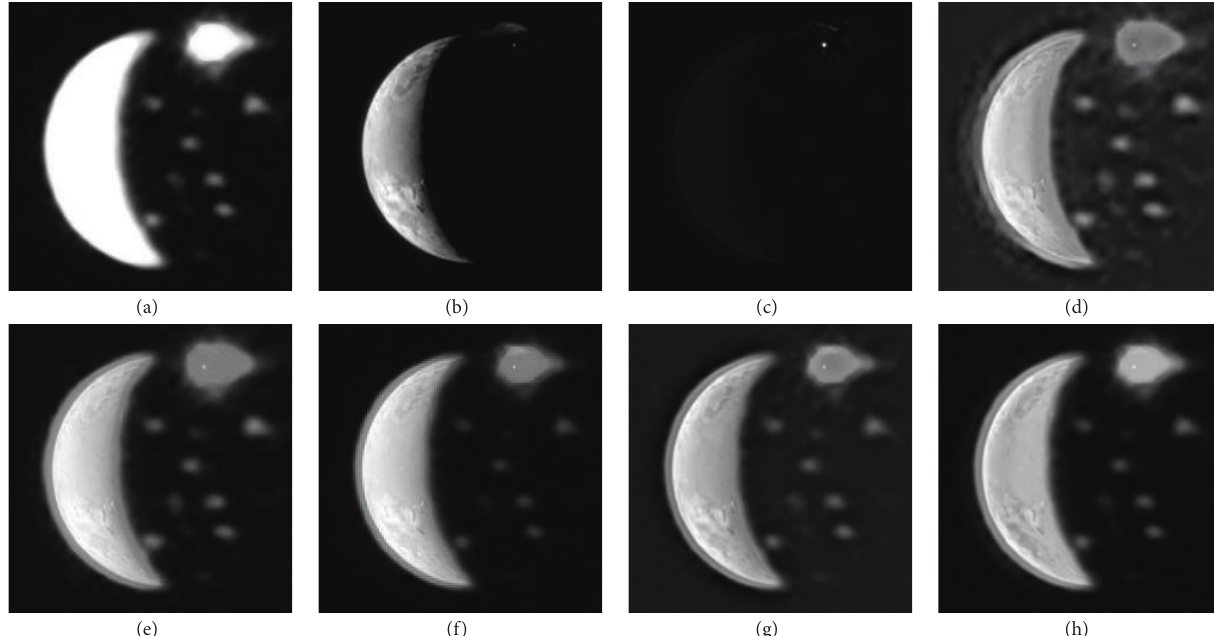
Figure 4: Jupiter’s moon: (a) IR image, (b) visible image, (c) RP [25] fusion, (d) DTCWT [26] fusion, (e) NSCT [27] fusion, (f) MSVD [28] fusion, (g) Ellmauthaler et al. [8] fusion, and (h) proposed fusion.